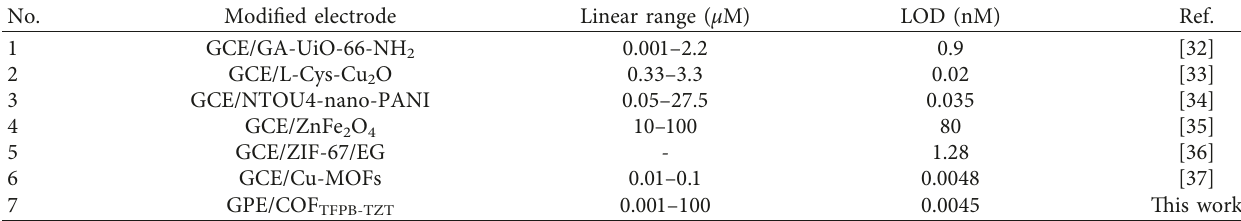
2+ in Tris-HCl buffer (pH Figure 6: Potential response curve for the GPE/COF 6.0). The concentrations of Hg 2+ are TFPB-TZT electrode to Hg (cid:28) 10 − 4 mol/L. The inset shows the linear portions of the calibration curve. The error bars are absolute errors deduced from at 1.0 10 − 9 ∼ 1.0 × × least three replicate measurements, and the RSDs for all the concentrations are in the range of 3.3 ∼ 11%. Table 1: Comparison of various nanomaterials based on sensors for Hg 2+